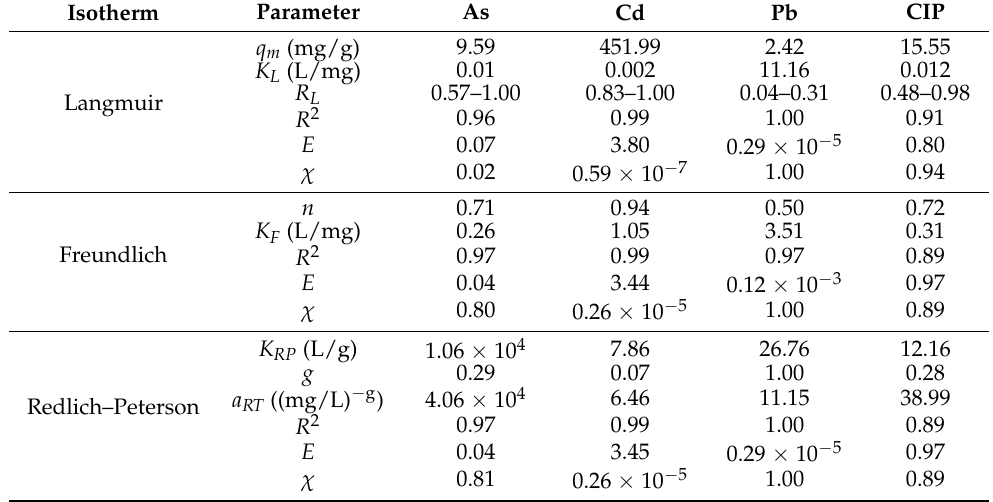
Figure 3. Adsorption isotherms of As, Cd, Pb and ciprofloxacin (CIP). Table 3. Isotherm constants of ciprofloxacin (CIP) and heavy metals on chitosan-biochar